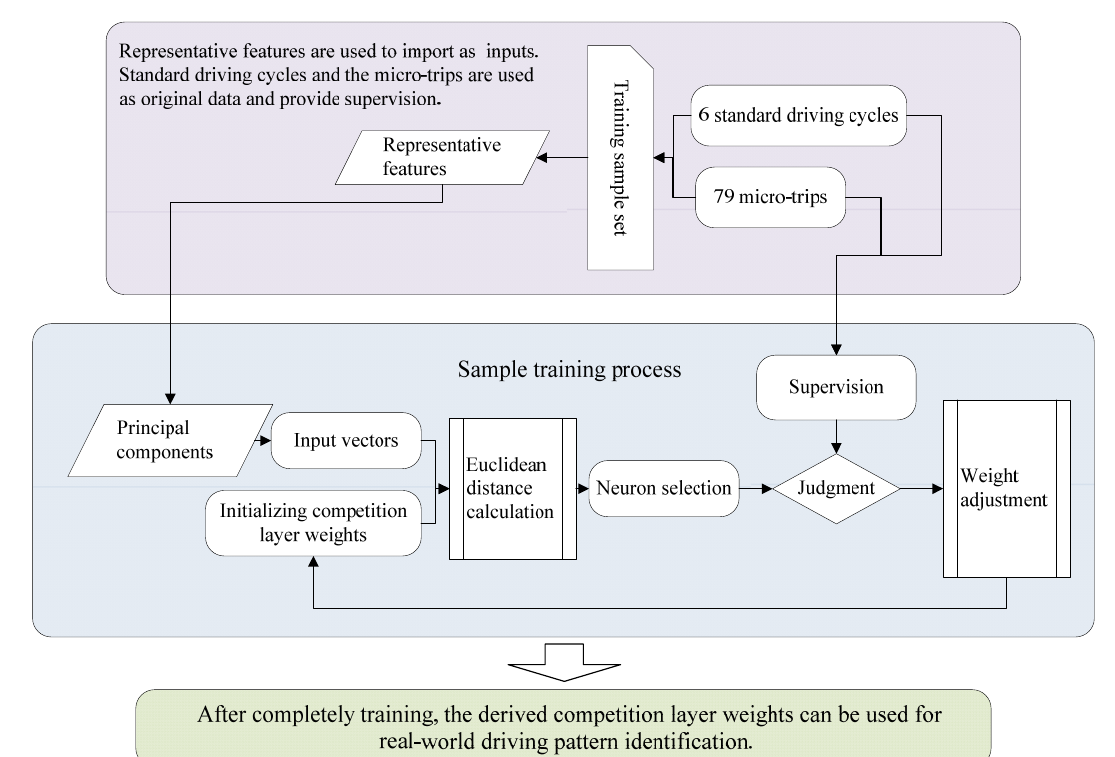
Figure 9. Sample training